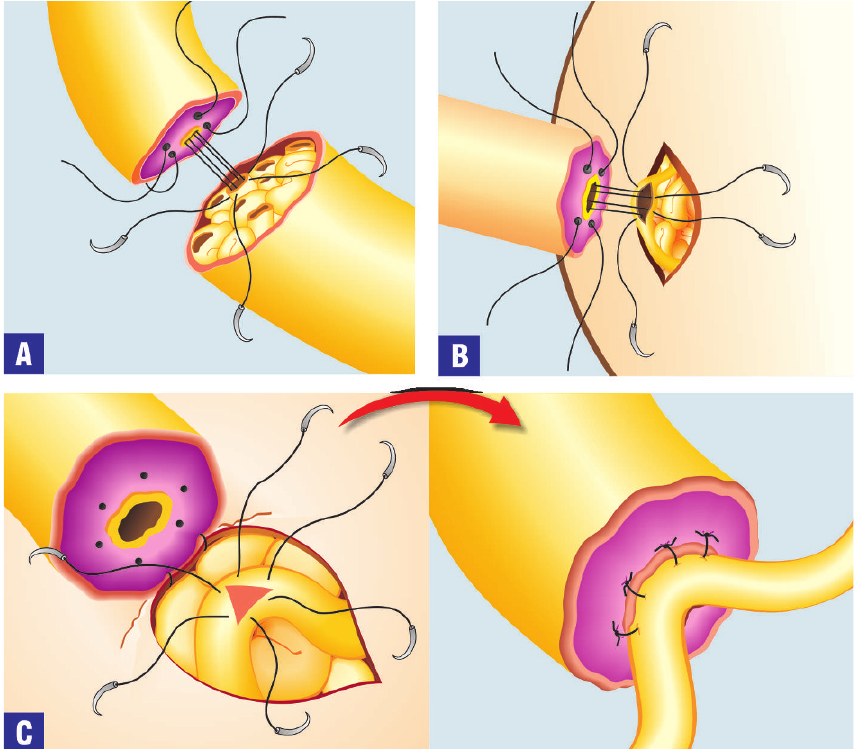
Figure 2 - Microsurgical Vasoepididymostomy Techniques. A) Illustration of the end-to-end, B) end-to-side, and C) triangulation end-to-